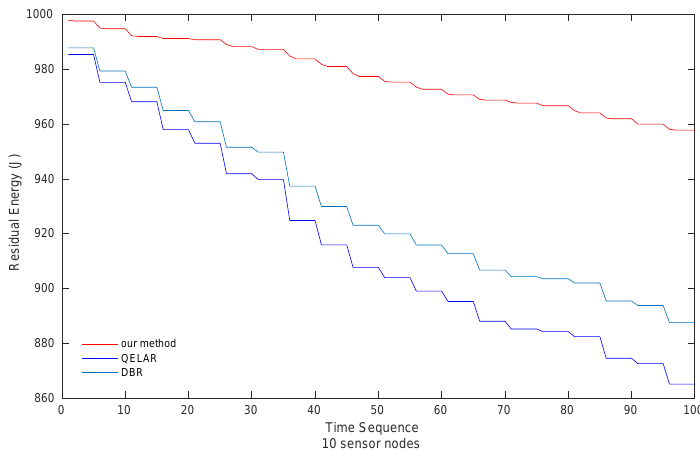
Figure 6. Residual energy of sensor nodes (10 sensor